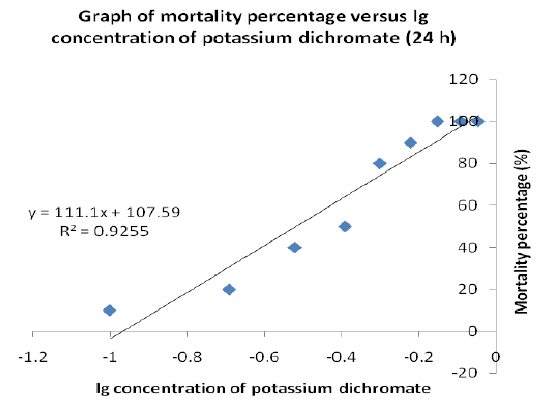
Figure 3. Brine shrimp lethality of potassium dichromate as a positive control at 24